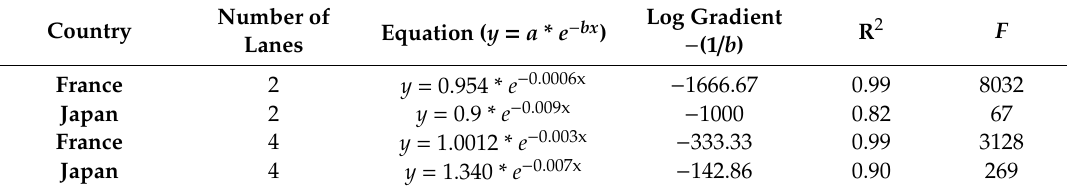
Table 3. Equation and statistical values of survival curves for departure time according to the country and the number of lanes. The six lanes condition in Japan does not appear here as no illegal crossings were observed. All p -values are < 0.00001.